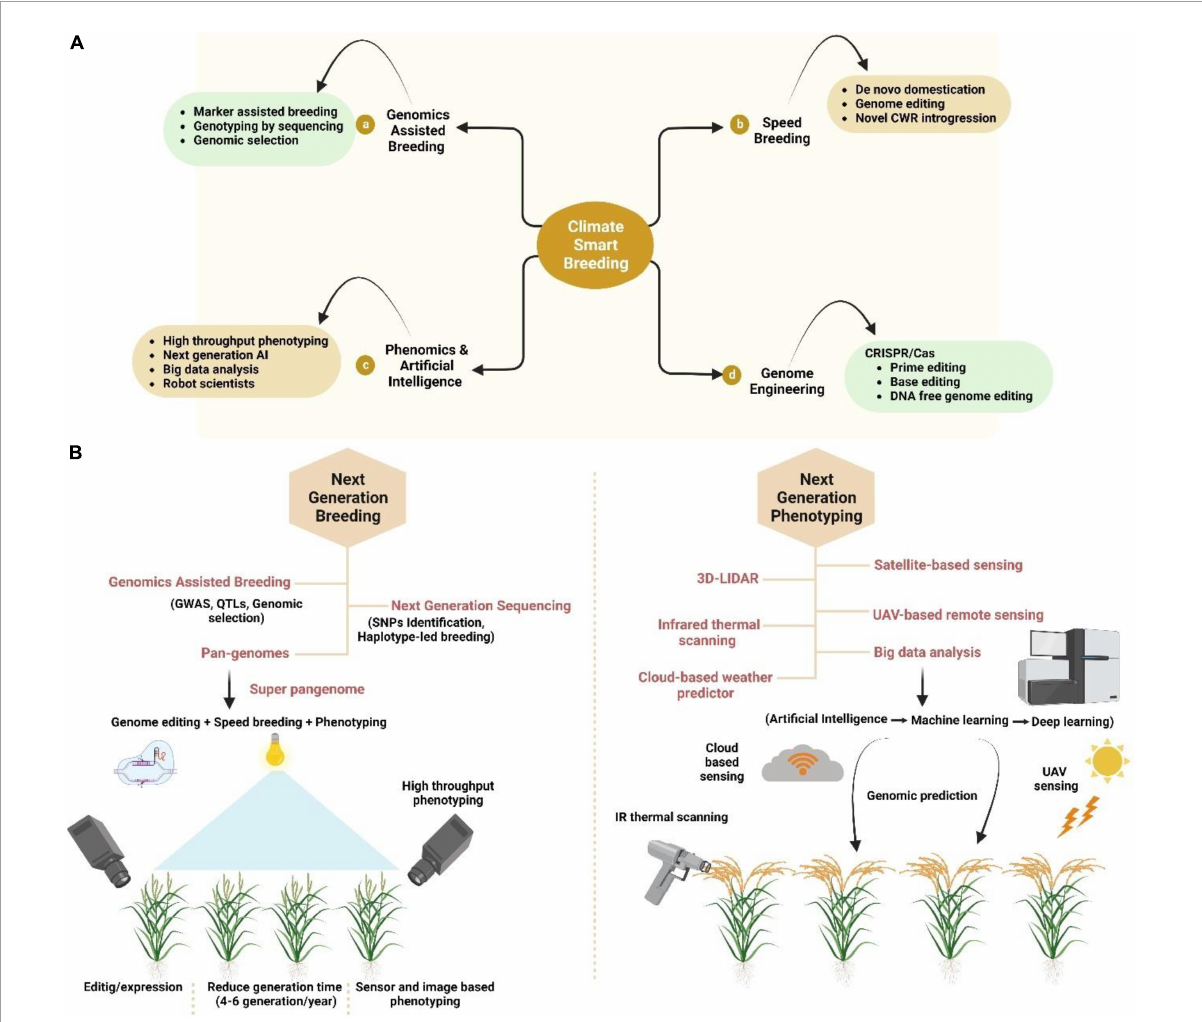
FIGURE2 Modern breeding for crop improvement under climate change scenario. (A) Climate-smart breeding is the combination of (a) genomics assisted breeding, (b) speed breeding, (c) phenomics and artificial intelligence (AI), and (d) genome editing. (B) Next generation breeding and phenotyping tools including breeding with genomics, next-generation sequencing (NGS) and Pan genomics while phenotyping includes 3D LIDAR, satellite-based sensing, UAV-based remote sensing, cloud-based sensing, and Infrared thermal prediction. All these breeding techniques and tools help in the sustainable production of crops as well as the selecting the high yield